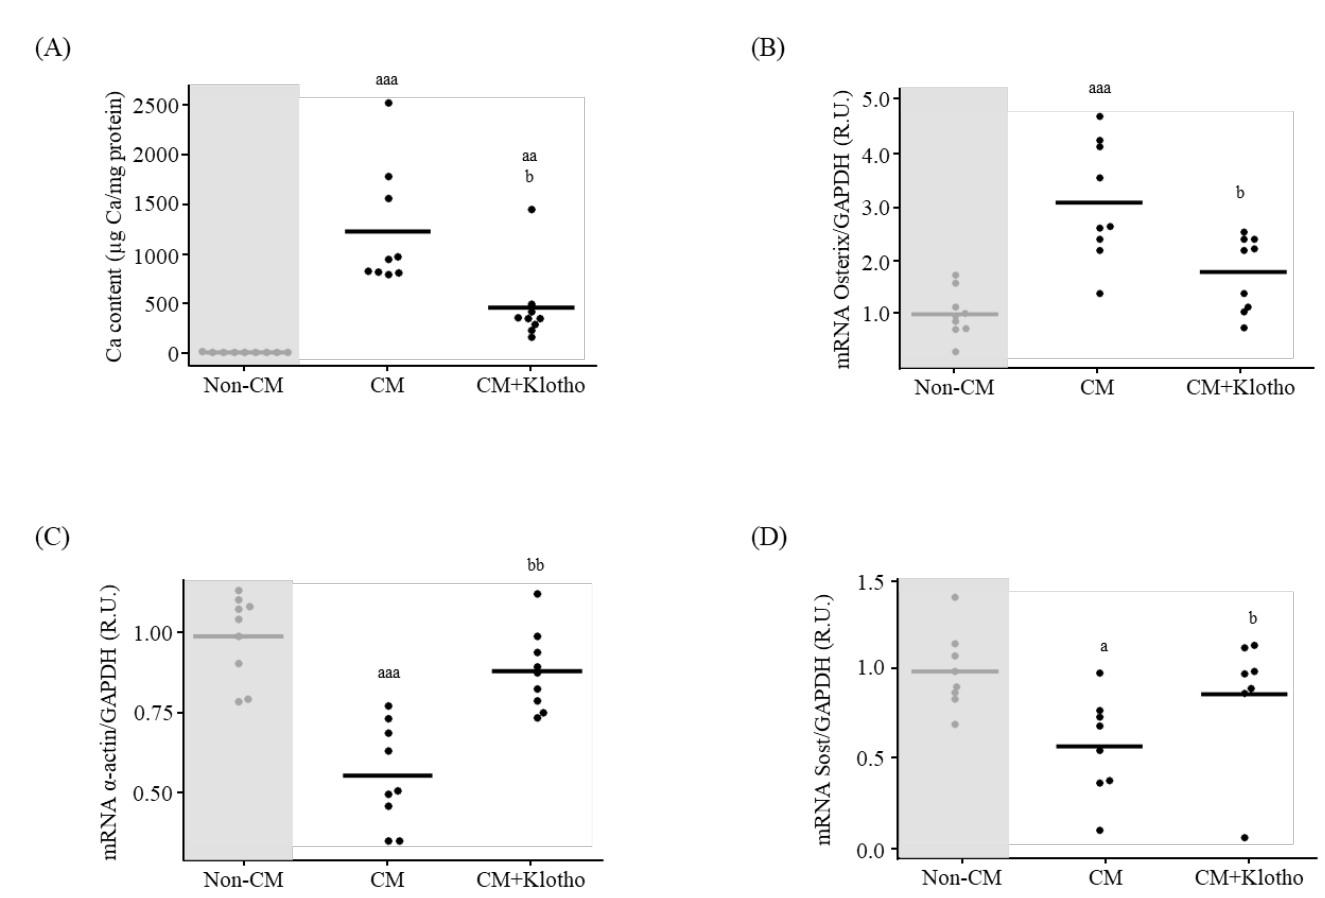
Figure 6. sKlotho effect on primary vascular smooth muscle cells (VSMCs) differentiation to osteoblast-like cells. ( A ) Ca content quantification, ( B ) Osterix ( C ) α -actin and ( D ) Sost mRNA levels in primary VSMCs exposed to non-calcifying medium (Non-CM), calcifying medium (CM) and CM+sKlotho for 3 days. All values are expressed relative to Non-CM condition as mean of 3 independent experiments by triplicates (horizontal lines). a p < 0.05, aa p < 0.01 and aaa p < 0.005 vs. Non-CM, b p < 0.05 and bb p <0.01 vs. CM. R.U., relative units vs. Non-CM. GAPDH was used as housekeeping